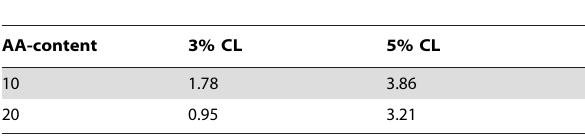
Table 2. Charge density (w% m m 2 3 6 10 3